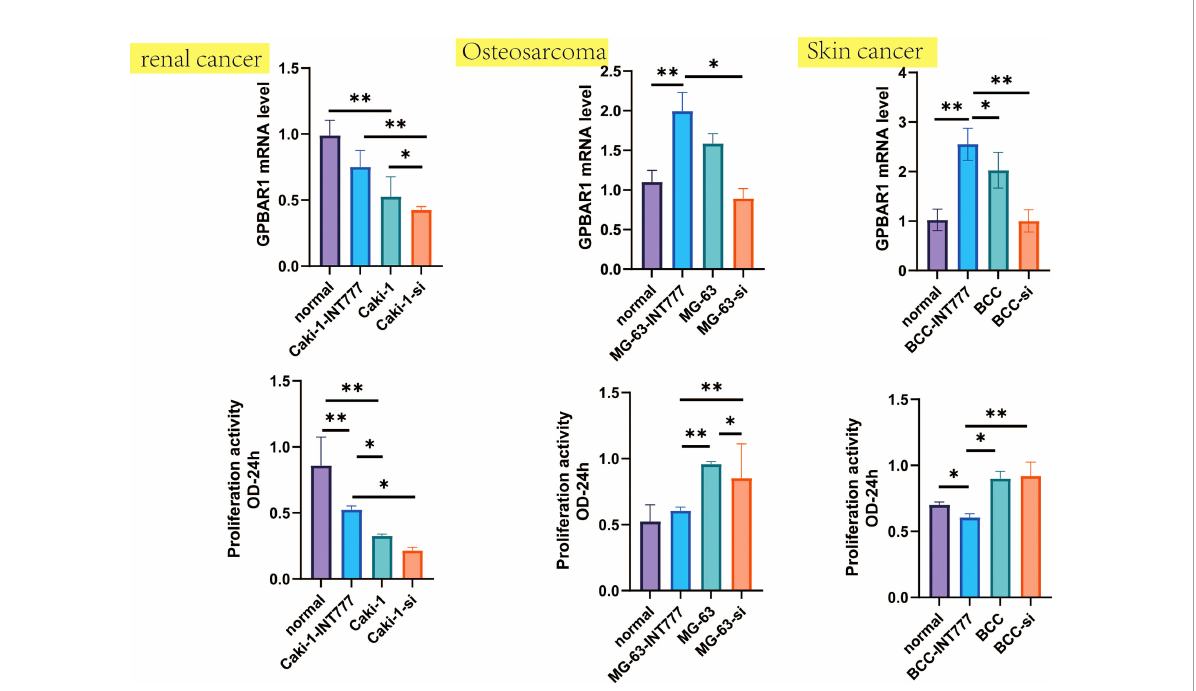
FIGURE 7 Proliferation activity and GPBAR1 mRNA were investigated by the CCK-8 test and the qPCR test, which compared normal renal cell, normal human osteoblasts, and normal skin cell with skin cancer, osteosarcoma, and renal cell carcinoma (each group: n = 8). *p < 0.05, **p <